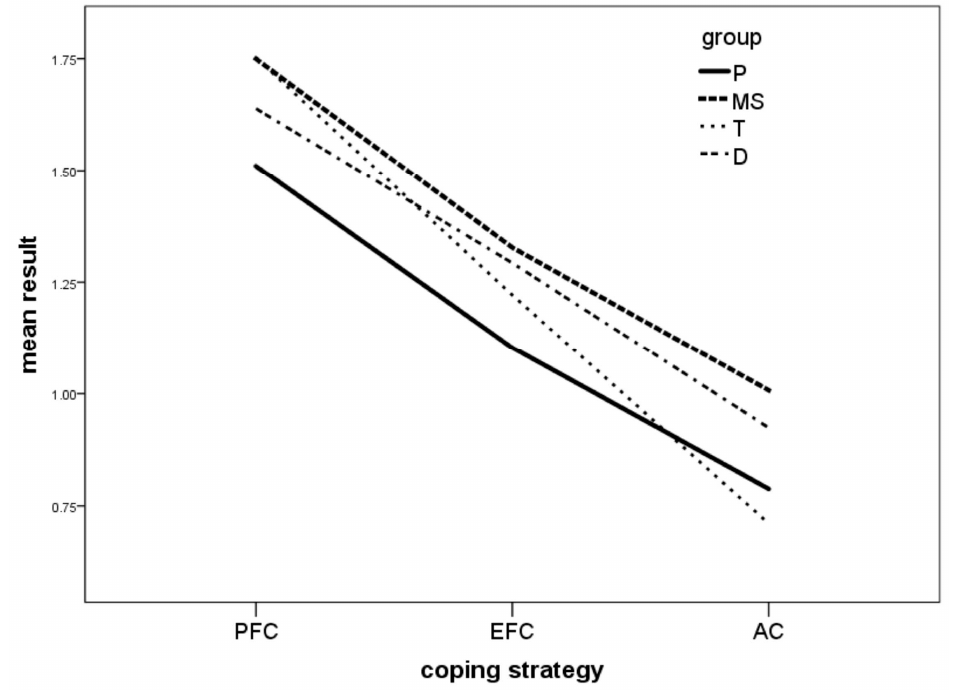
Figure 1. Coping strategies in four groups of patients—interaction effect. P—psoriasis, MS—multiple sclerosis, T—kidney transplant recipients, D—dialysis patients. PFC—problem-focused coping, EFC—emotion-focused coping, AC—avoidant coping.